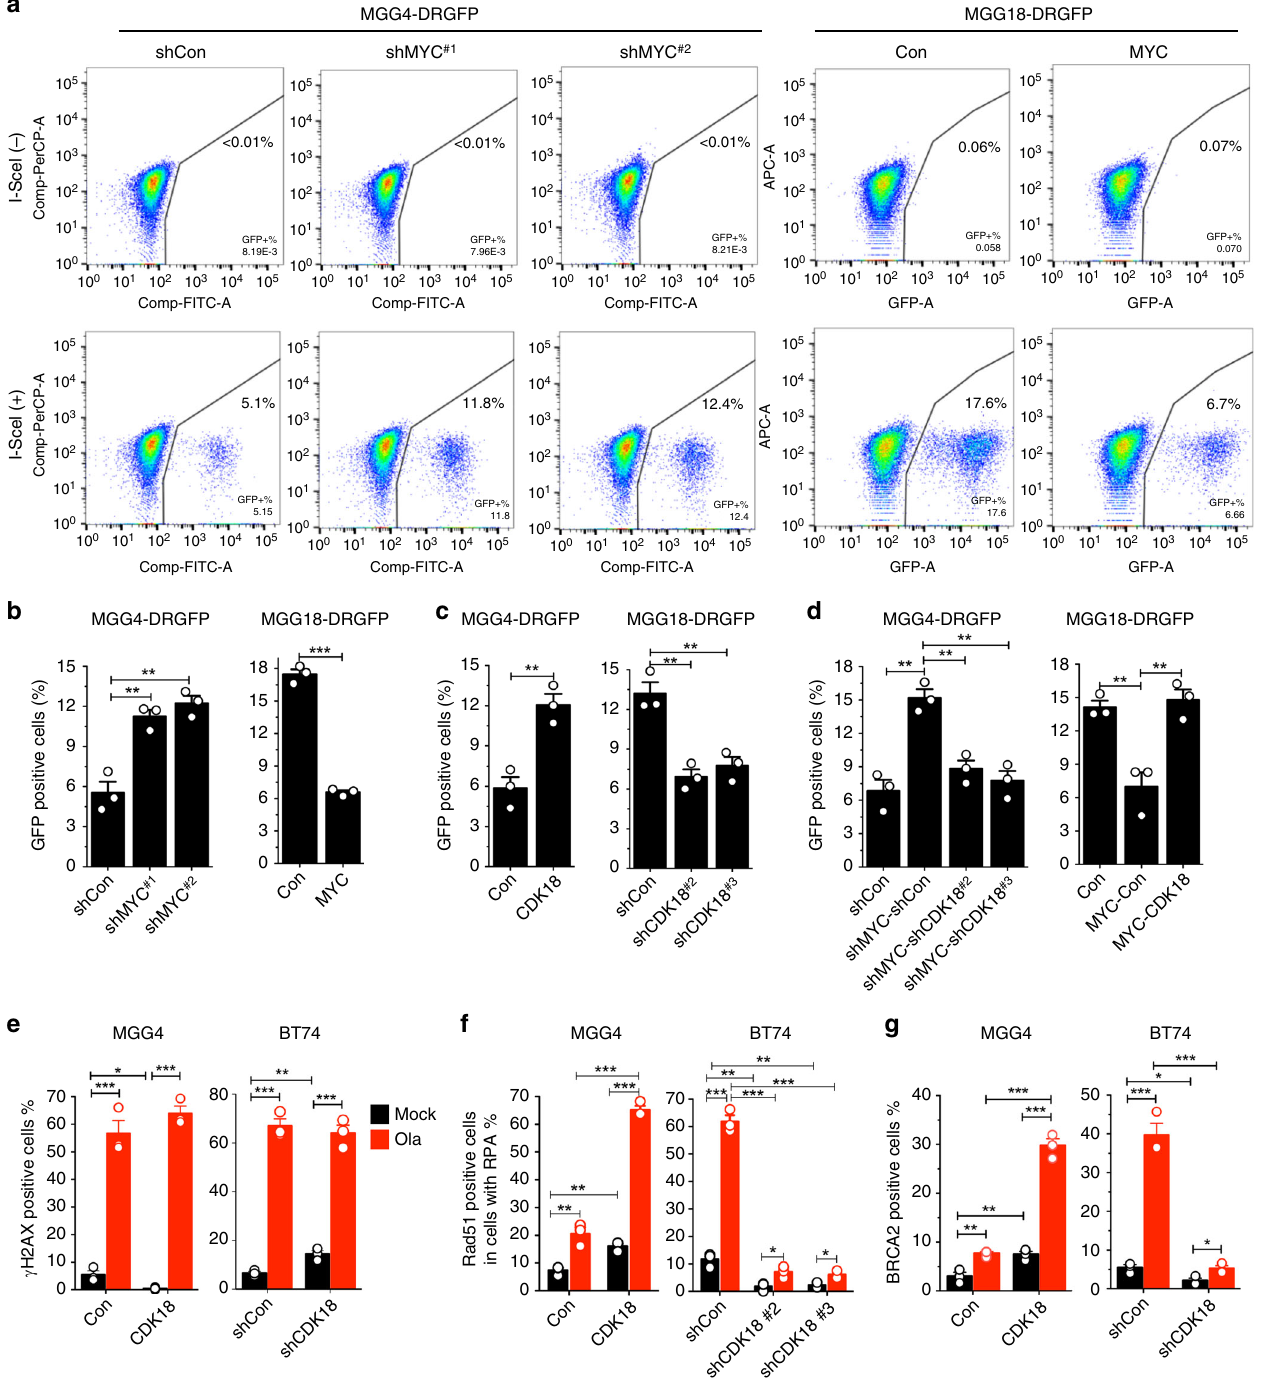
Fig. 4 MYC inhibits and cyclin-dependent kinase 18 (CDK18) promotes homologous recombination (HR) in glioblastoma stem-like cells (GSCs). a Representative fl ow cytometry plots showing HR in MGG4-DRGFP expressing shRNA-Control (shCon) or shRNA-MYC (shMYC; two independent sequences) and MGG18-DRGFP expressing empty vector (Con) or MYC. GSCs were induced with doxycycline for 6 days before infection with lentivirus with ( + ) or without ( − ) I-SceI expression, followed by fl ow cytometry to measure green fl uorescent protein (GFP)-positive cells (right quadrant) at 5 days after infection. b HR ef fi ciency (percentage of GFP + ) from a and two additional independent experiments. c HR ef fi ciency in MGG4-DRGFP-CDK18 or MGG18-DRGFP-shCDK18 (two independent sequences). Western blot and representative fl uorescence-activated cell sorting (FACS) plots shown in Supplementary Fig. 7. d HR ef fi ciency in MGG4- or MGG18-DRGFP with double knockdown or overexpression of MYC and CDK18. Western blot and representative FACS plots shown in Supplementary Fig. 8. e – g Quanti fi cation of immuno fl uorescence staining of γ H2AX ( e ), Rad51 positive foci in RPA positive ( f ), and BRCA2 ( g ) foci in GSCs with CDK18 overexpression or knockdown (sh) (shCDK18 #2 in e , g ). Cells were treated with olaparib (Ola; 15 μ M) or mock for 12 h before staining. Cell with ≥ 5 foci/cell were counted as positive. Representative images shown in Supplementary Fig. 9. Mean ± SEM, from three independent experiments. * p < 0.05, ** p < 0.01 and *** p < 0.001, t